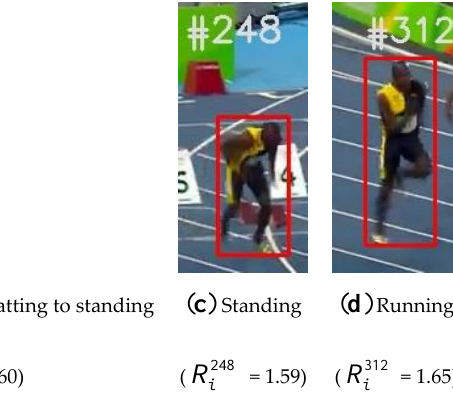
Figure 3. Postures during the race and the corresponding aspect ratios.